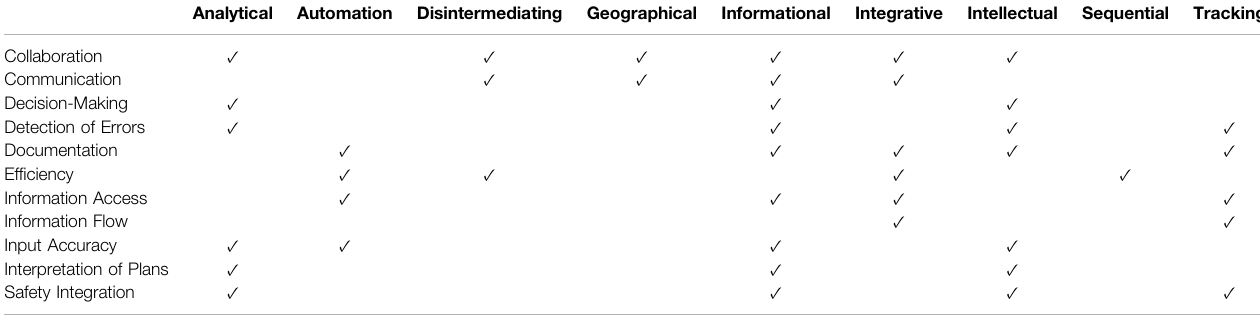
TABLE 3 | Matrix of AR impact areas and PSP